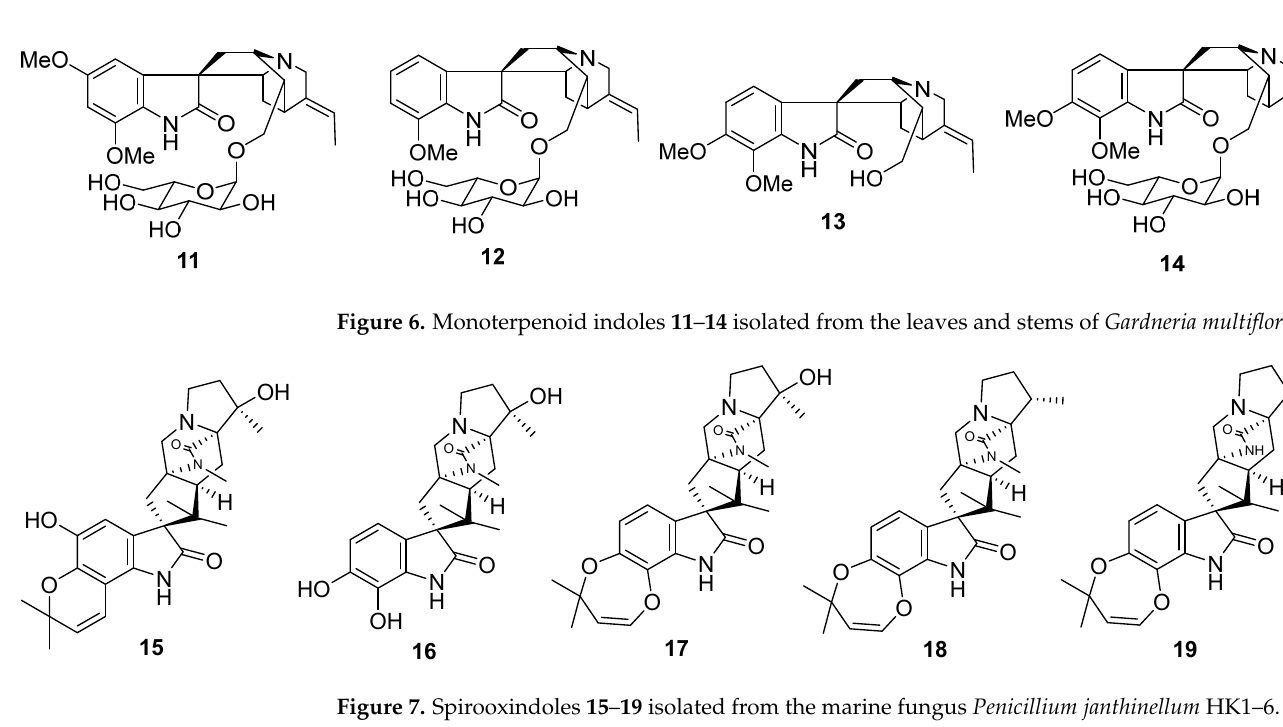
Figure 7. Spirooxindoles 15–19 isolated from the marine fungus Penicillium janthinellum HK1–6.